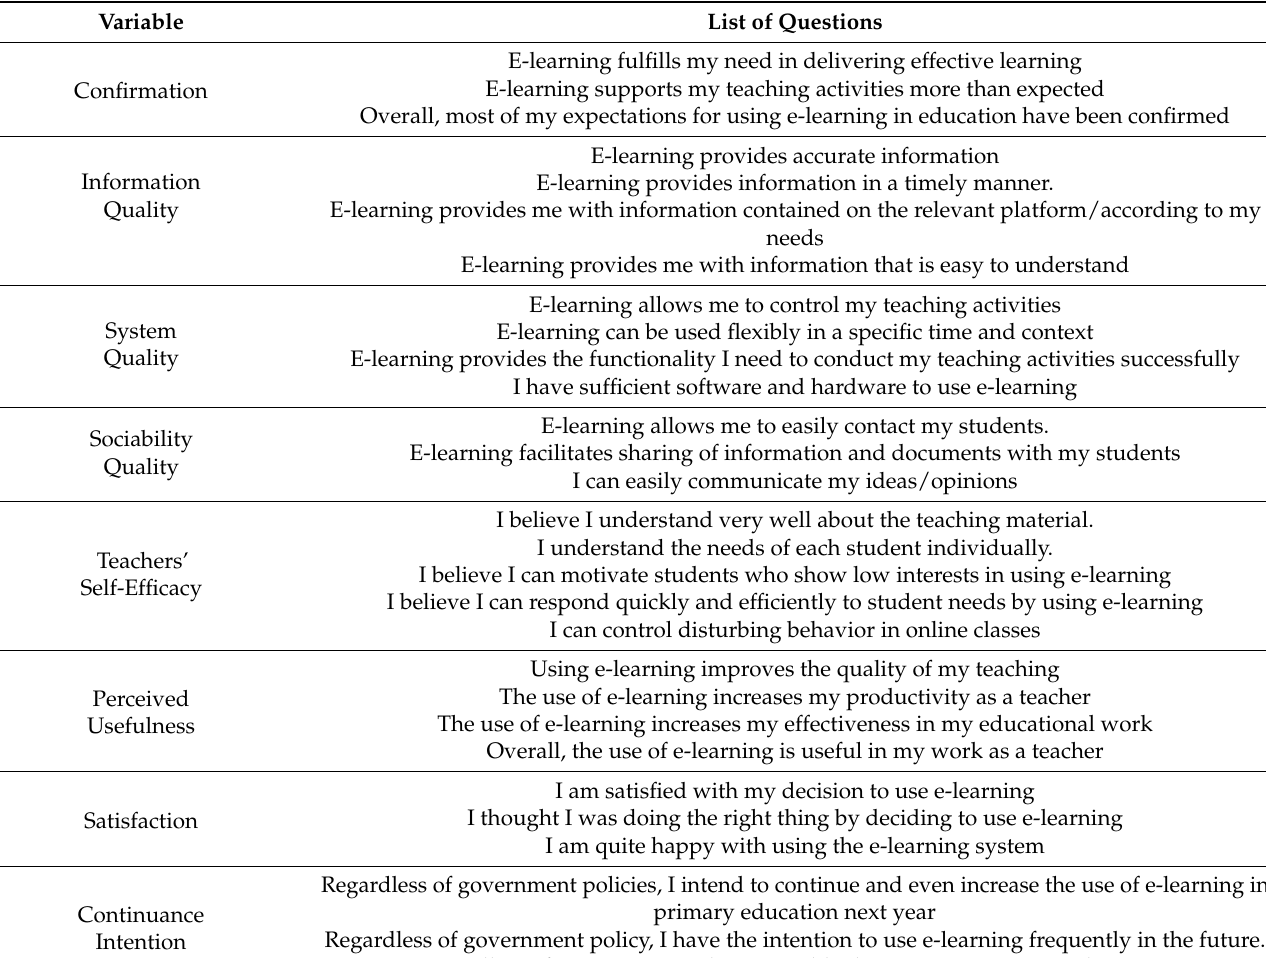
Table 2. List of